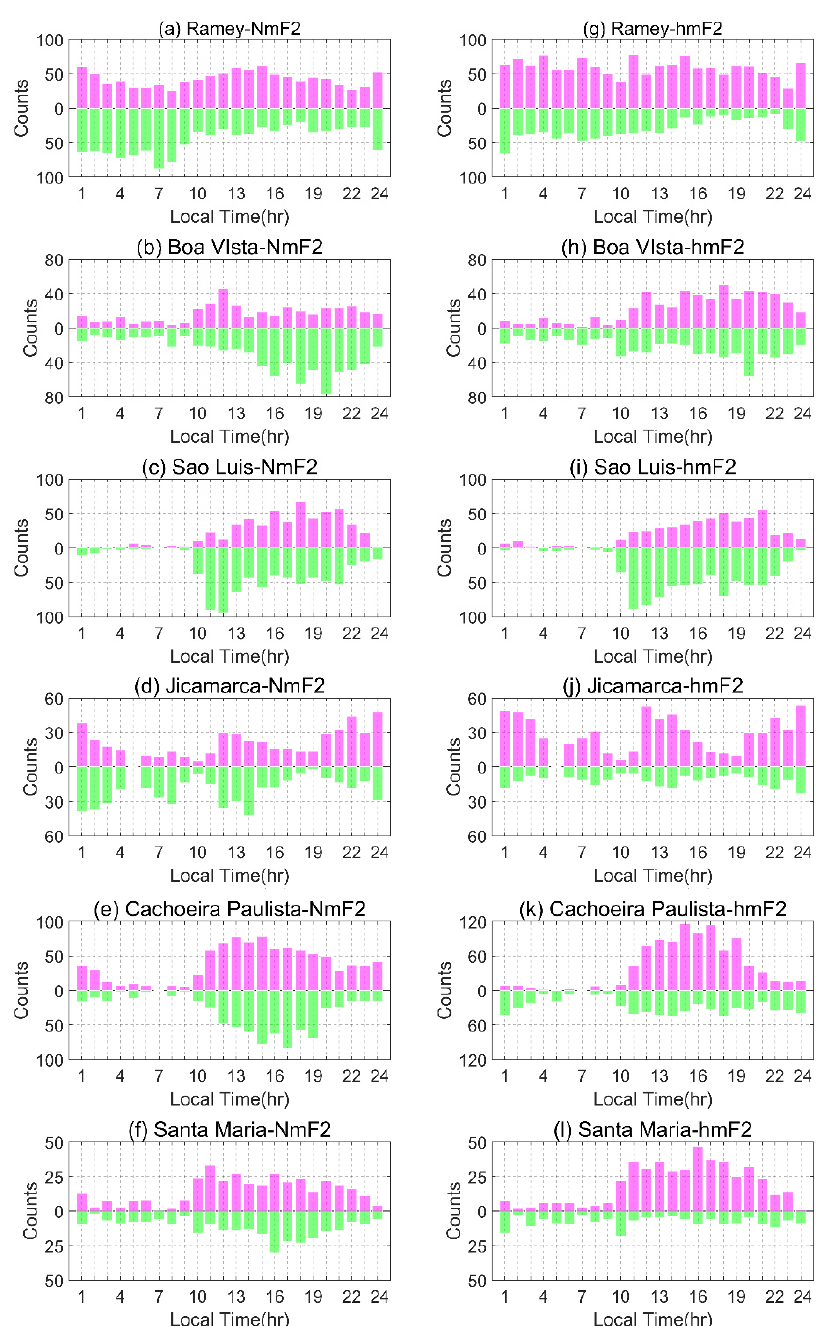
Figure 7. Numbers of the positive (magenta) and negative (green) difference values of N m F 2 ( left column ) and h m F 2 ( right column ) resulting from COSMIC-2 and ionosonde at each station for bias analyses.